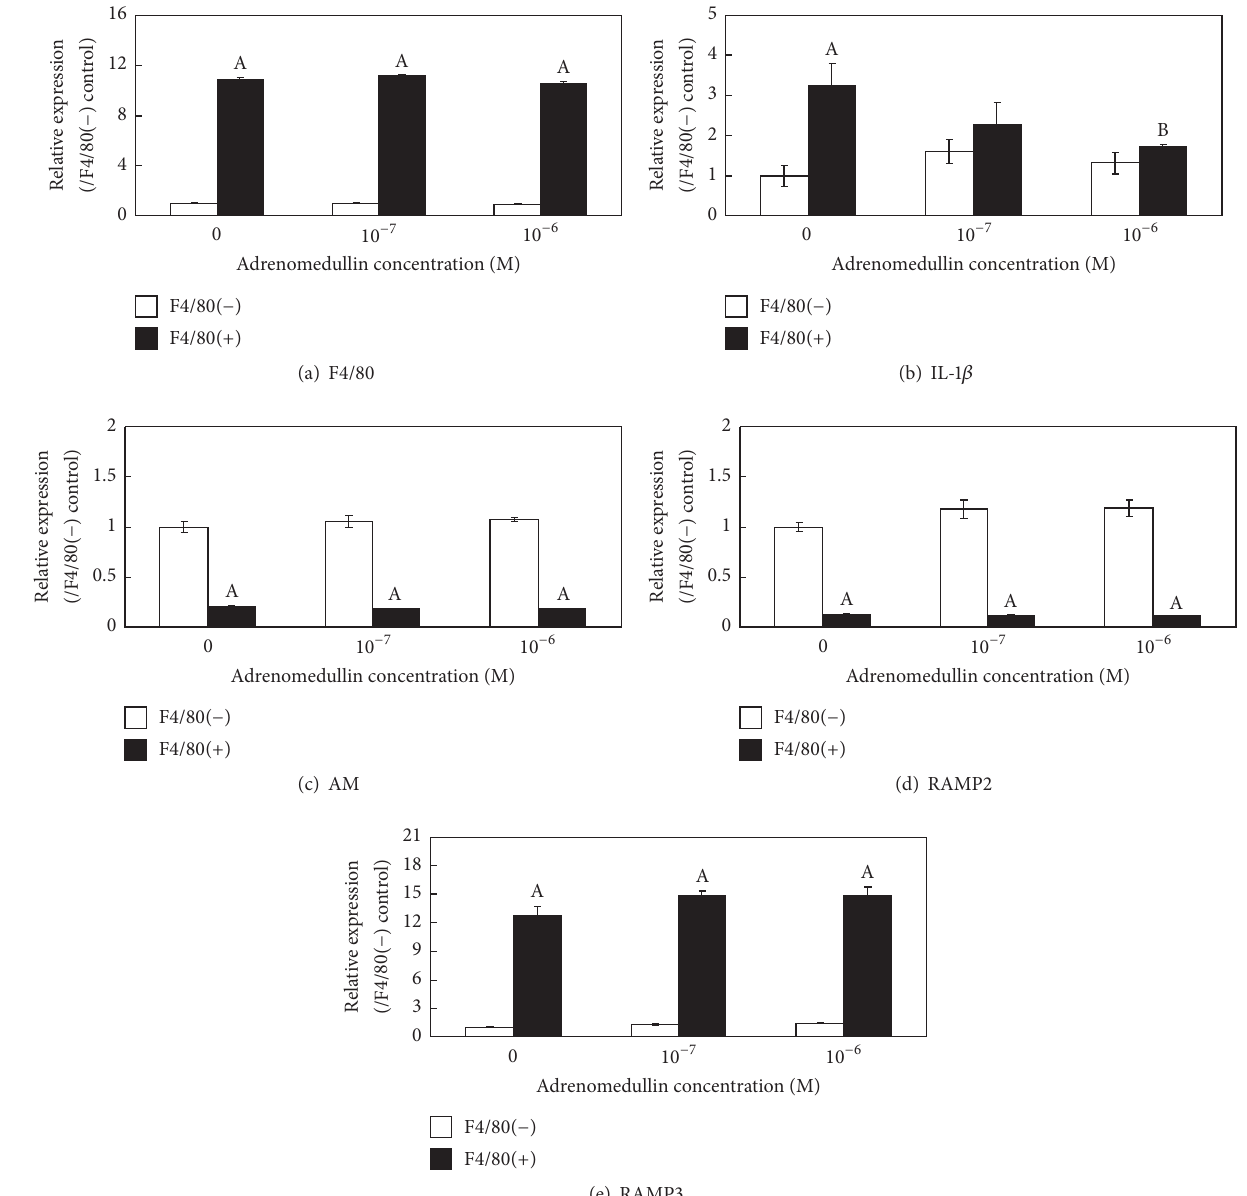
Figure 5: Effects of adrenomedullin (AM) on interleukin- (IL-) 1 𝛽 gene expression in cultured primary synovial fibroblasts and macrophages. The effects of AM on F4/80 , IL-1 𝛽 , AM , RAMP2 , and RAMP3 gene expression in cultured primary synovial fibroblasts (F4/80-negative fraction) and macrophages (F4/80-positive fraction) were examined by real-time PCR. A 𝑃 < 0.05 compared with F4/80-negative fraction. B 𝑃 < 0.05 compared with fraction matched-untreated